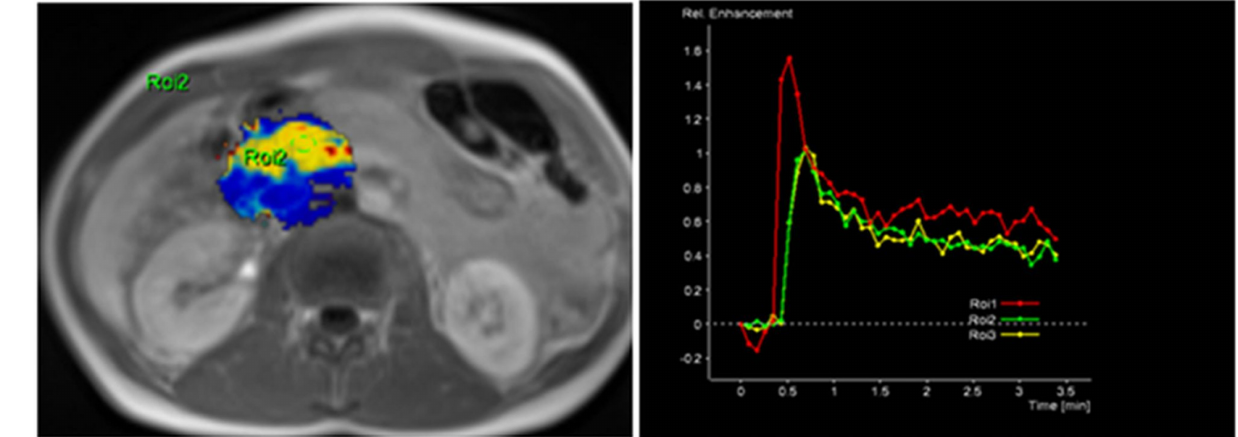
Figure 2. MRI perfusion images of non-tumorous pancreatic parenchymal tissue in the head of the pancreas with TSIC—Type I (characterized by fast enhancement and fast washout). Type I pattern enhancement was found in all tissues from control group patients.